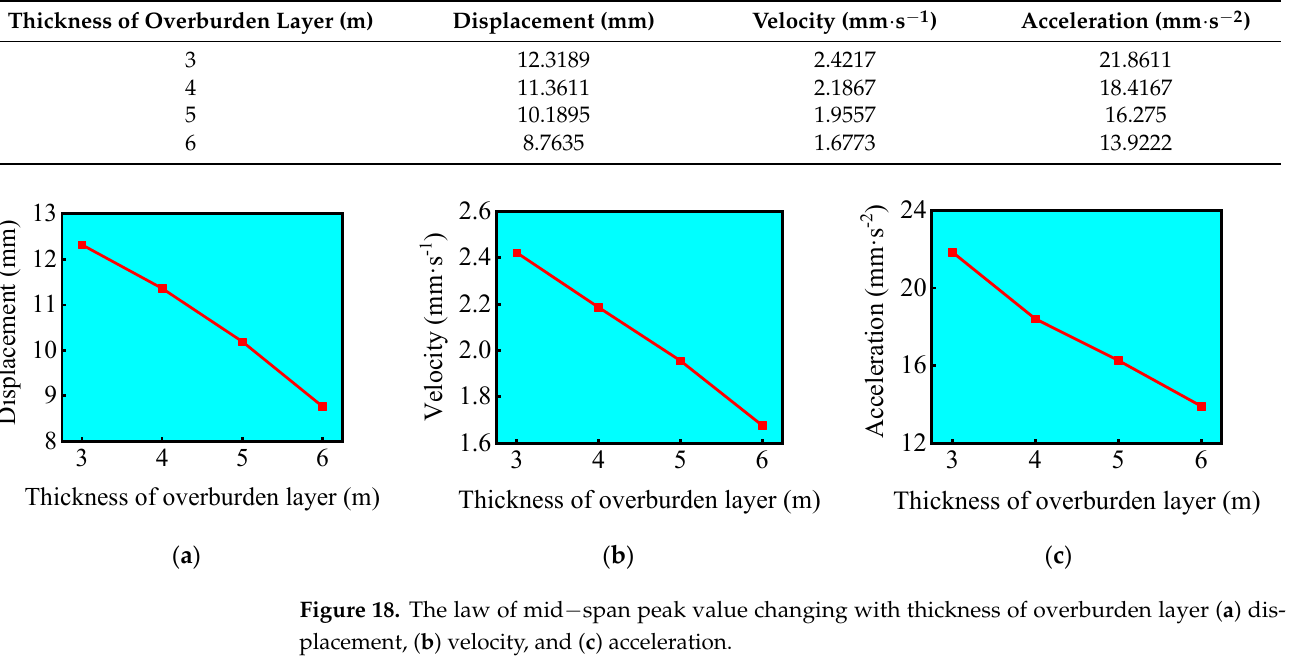
Figure 17. Peak value variation rule of different measuring points when the thickness of overburden layer changes ( a ) displacement, ( b ) velocity, and ( c ) acceleration. Table 4. Results of peak displacement, velocity, and acceleration at the mid − span measuring point when the thickness of overburden layer changes.